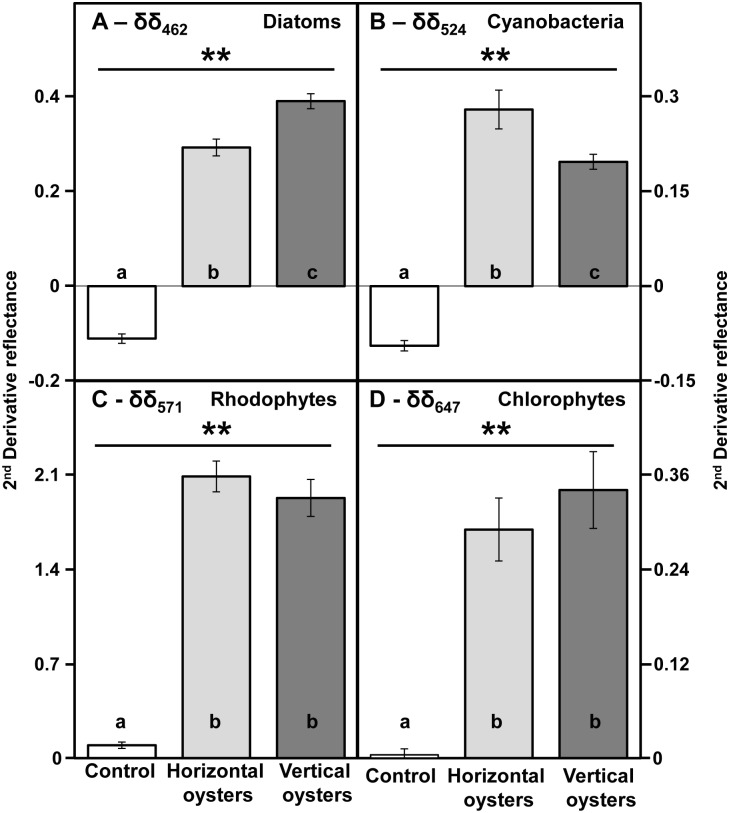
Comparison of mean second derivatives between vertically-growing (dark grey) and horizontally-growing (light grey) oysters.Diagnostic wavelengths: 462 nm for diatoms, 524 nm for cyanobacteria, 571 nm for rhodophytes, 647 nm for chlorophytes. Bright white shells from dead oysters washed onto the shore were used as a control with no biocolonisation. Means are presented with their confidence intervals at 95%. The double asterisk indicates a highly statistically significant difference (p<0.01) with the control. Within each graph, bars sharing the same letter are not significantly different (PERMANOVA, pairwise tests, p > 0.05).